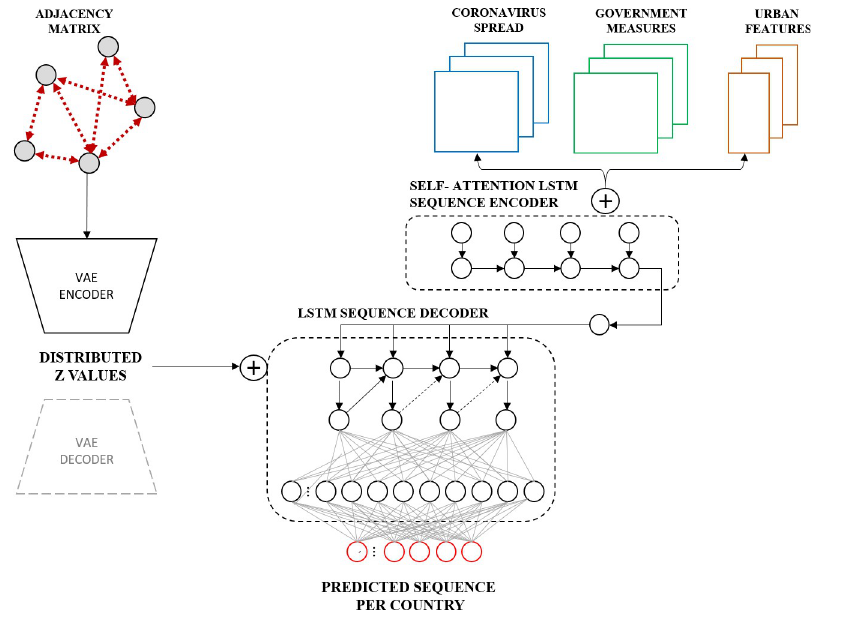
Fig 2. The proposed variational LSTM autoencoder